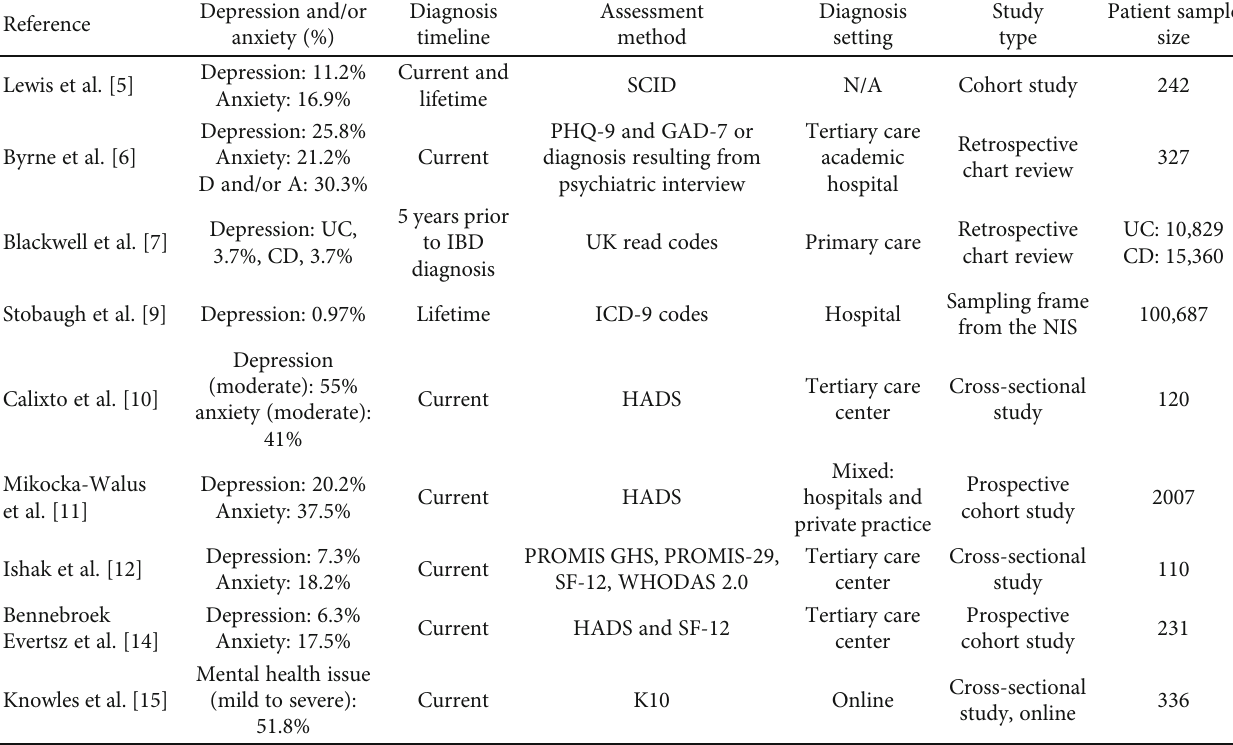
Table 1: The prevalence of depression and anxiety in various IBD